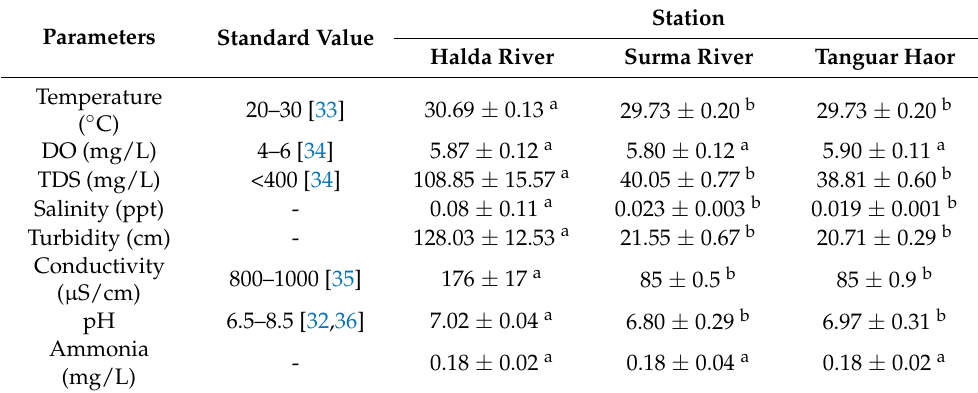
Table 4. Water quality parameters of different sampling stations during the study